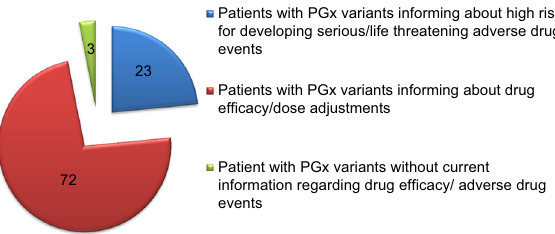
Fig. 2 Signi fi cance of pharmacogenetic (PGx) information in 98 subjects. Based on published guidelines, mined PGx data from targeted genotyping and WGS platforms were subdivided into three different categories by considering the signi fi cance of